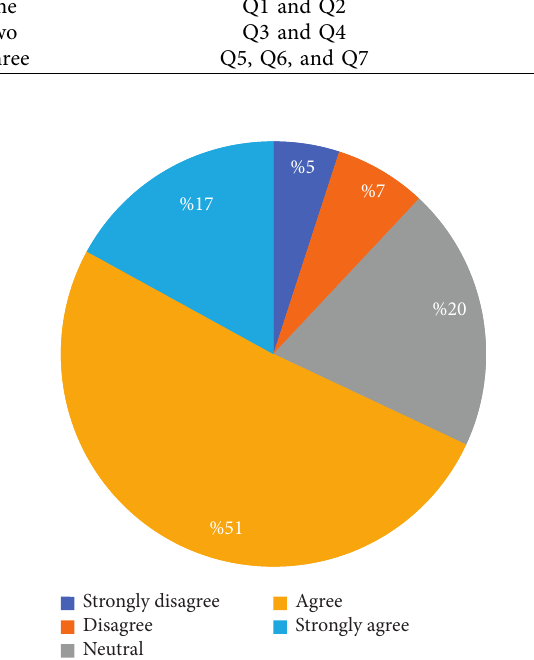
Figure 4: Q2: I think open data can make a huge difference.